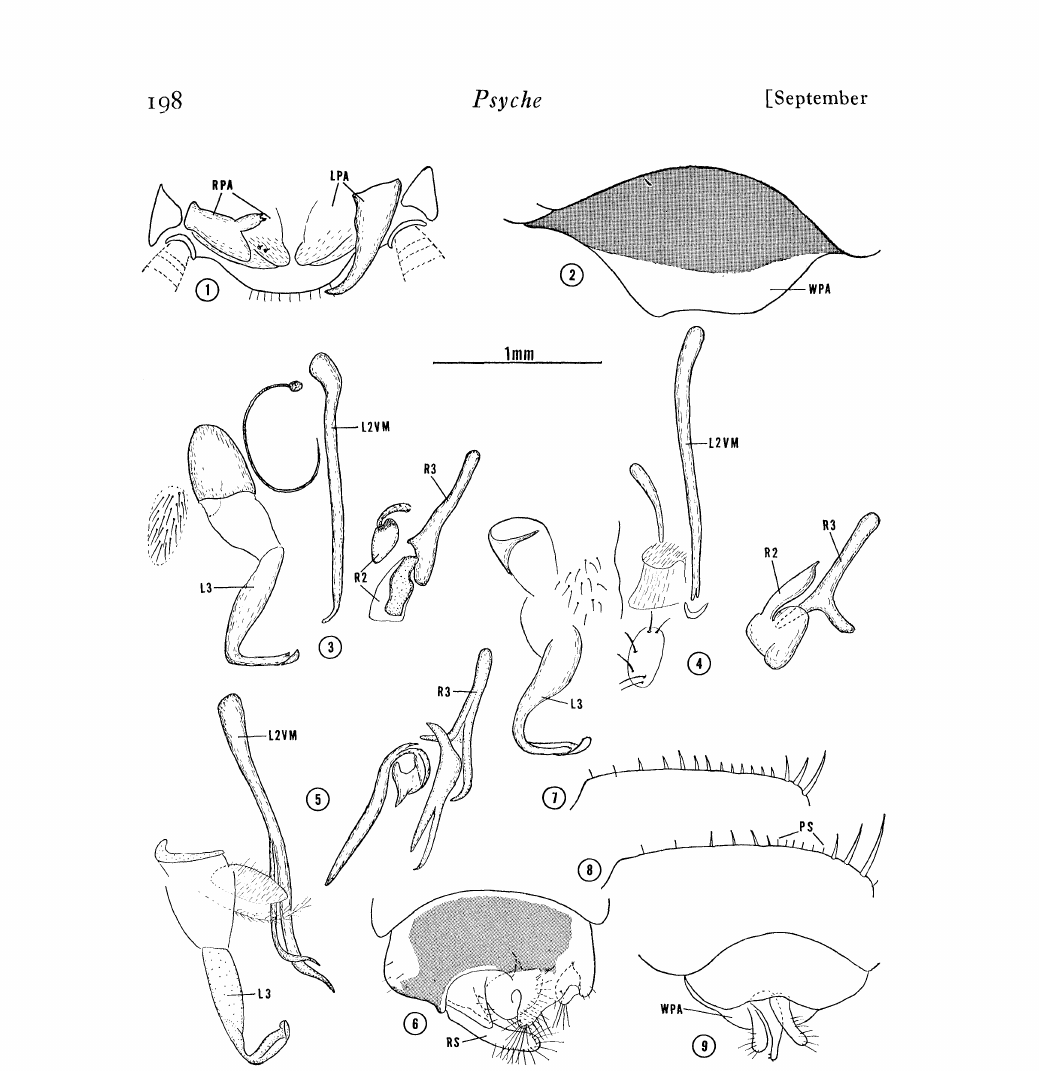
Figs. 1-9. Male genitalia of Loboptera, Lobopterella, and /lgmoblatta (All figures except no. 2 drawn from KOH